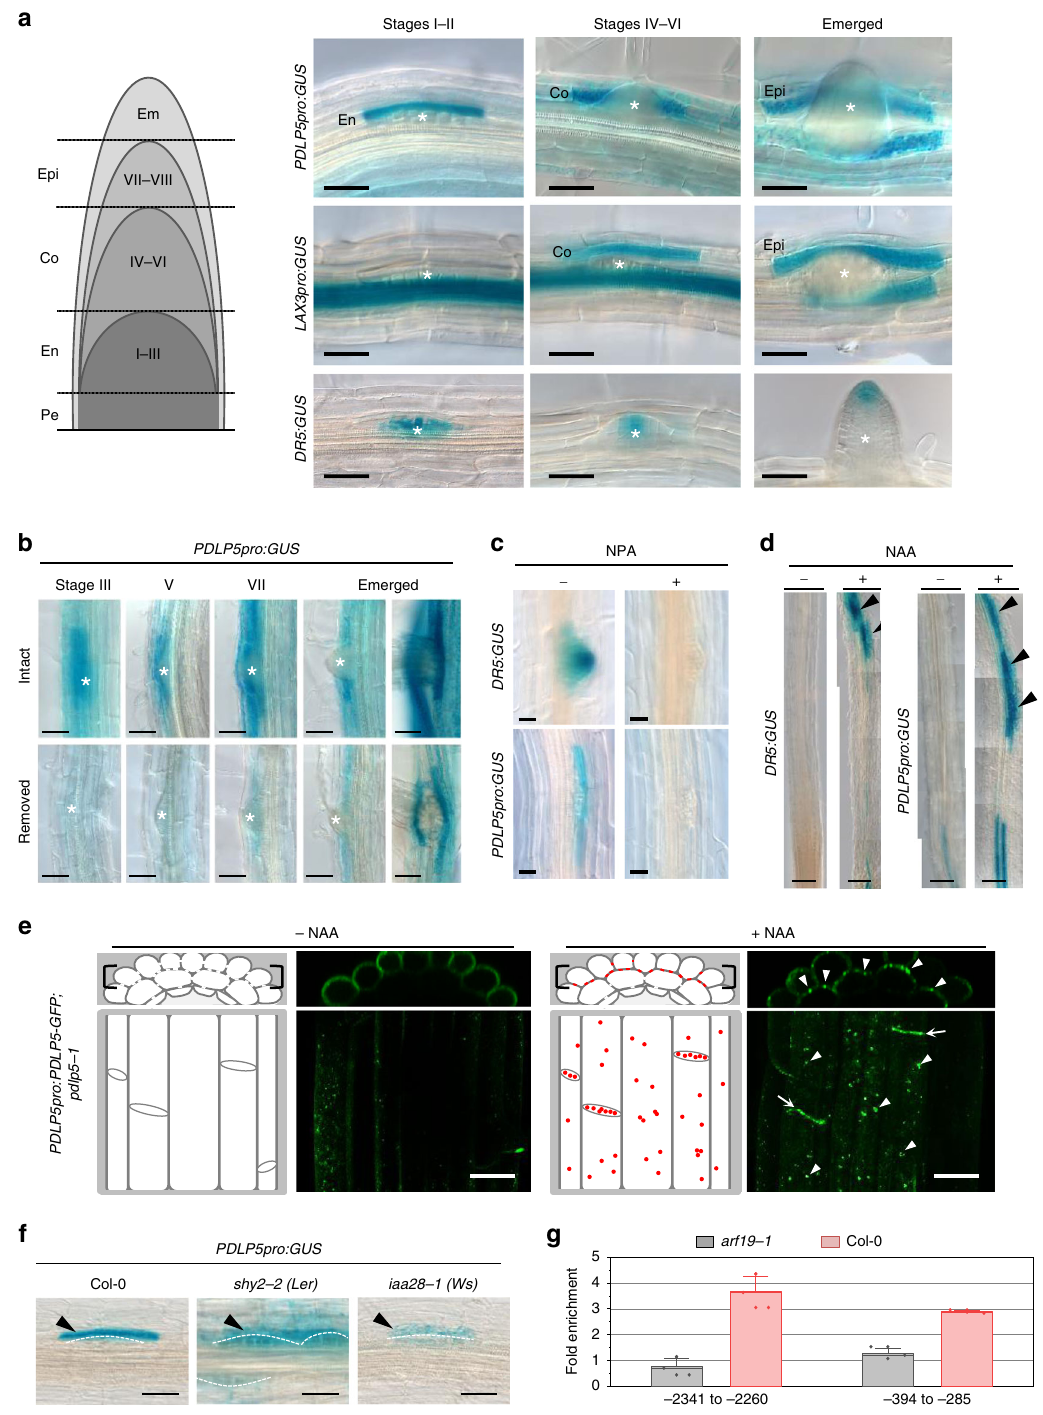
pattern — punctate signals at the cell wall junctions: at stage II, PDLP5-GFP signals were associated with two En cells positioned directly above the newly-forming LRP and speci fi cally plasmo- desmata at En – En, En – Pe, and En – Co cell wall junctions. At stages III and V, plasmodesmal signals were detected primarily in the walls surrounding two Co cells located directly above the two initial En cells (Fig. 2a, darts). Strong plasmodesmal labelings were detected at the Co – En and Co – Epi junctions as well as at